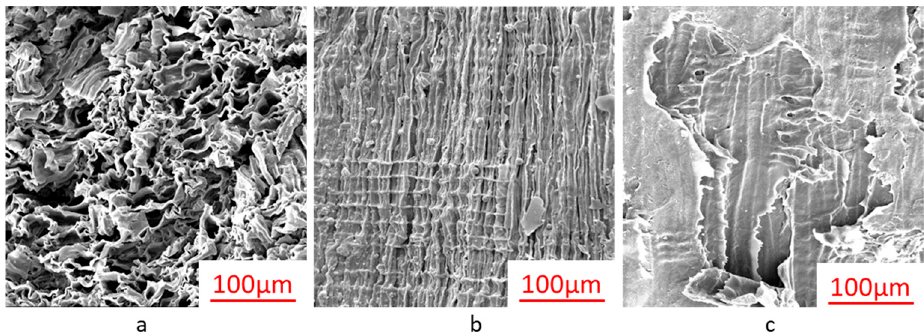
Figure 4. SEM micrographs of ancient shipwreck wood (sample 1#) in the transverse ( a ), radial ( b ), and tangential ( c ) sections.